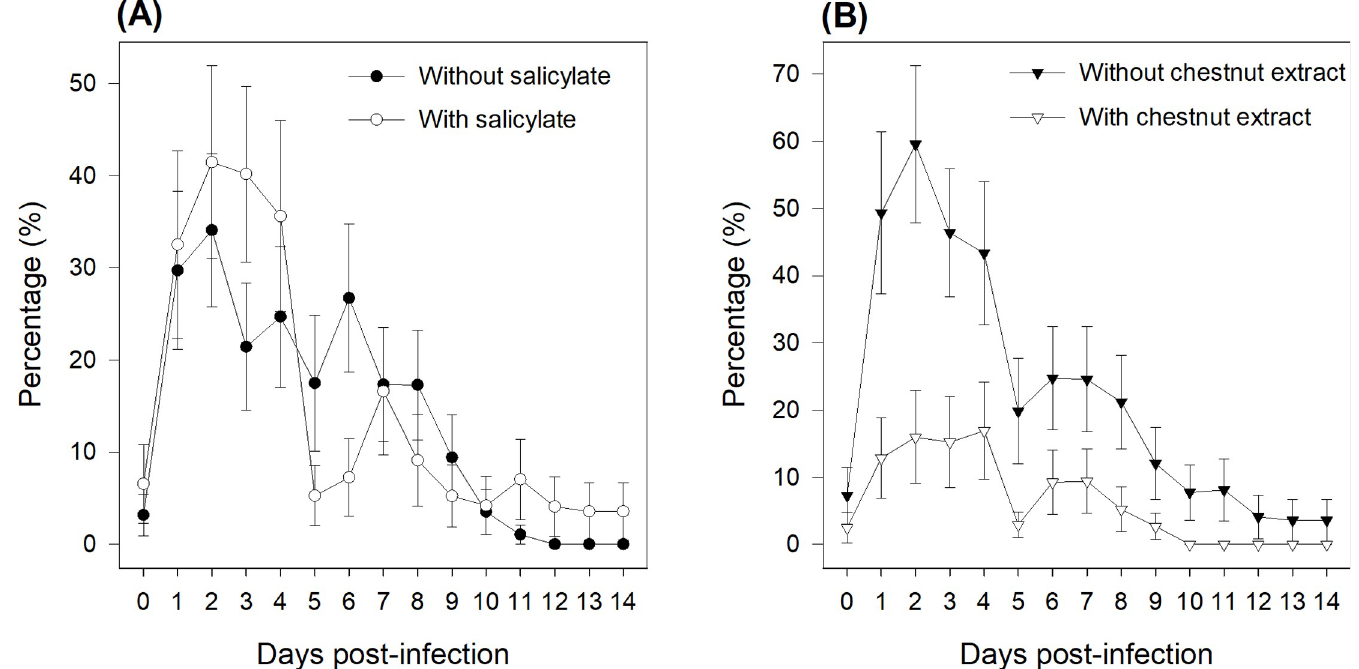
Fig 2. Effects of sodium salicylate supply (A) and chestnut extract supplementation (B) on the percentage of piglets with diarrhea from days 0–14 post-infection. Fecal scores � 3 were termed diarrhea. From days 0–4, pigs (N = 36) in the SA+ group were offered a daily dose of sodium salicylate (35 mg/kg BW per day, sodium salicylate, ReagentPlus 1 , S3007, Sigma-Aldrich Chemie GmbH; Buchs, Switzerland). From days 0–4, pigs (N = 36) in the SA- group were offered a daily dose of tap water. Pigs (N = 36) in the CE- group had ad libitum access to a control standard starter diet, which was formulated according to the Swiss feeding recommendations for pigs (Agroscope, 2017). Pigs (N = 36) in the CE+ group had ad libitum access to the chestnut extract (CE)-supplemented diet, in which wheat straw in the CE- diet was substituted for with 2% CE (Silvafeed Nutri P/ENC for Swine; Italy). P-values for the main effects: SA supply: P = 0.72; CE supplementation: P < 0.001; Time: P < 0.001; SA × Time: P = 0.003.